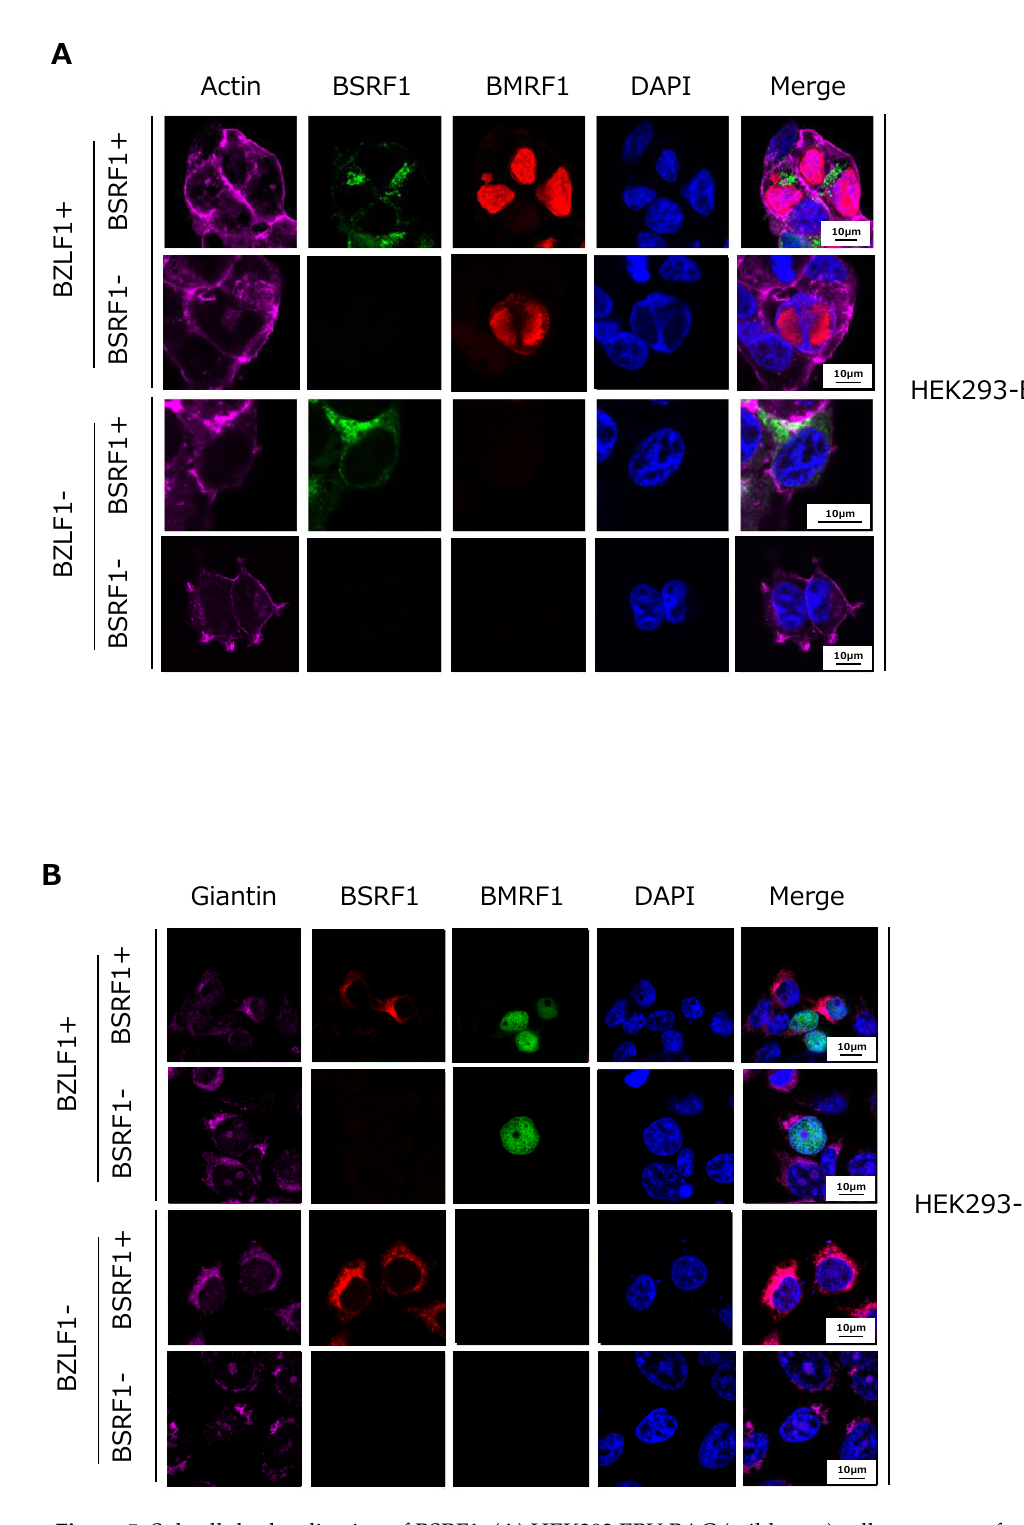
Figure 5. Subcellular localization of BSRF1. ( A ) HEK293 EBV-BAC (wild-type) cells were transfected by lipofection with the expression vectors indicated at left. After 2 days the cells were fixed, stained with phalloidin (actin, purple), an anti-HA (BSRF1, green) antibody, an anti-BMRF1 (red) antibody, and DAPI (blue), then visualized using a confocal laser microscope. ( B ) HEK293 EBV-BAC (wild-type) cells were transfected likewise, and stained with an anti-giantin (Golgi apparatus, purple) antibody, an anti-HA (BSRF1, green) antibody, an anti-BMRF1 (red) antibody, and DAPI